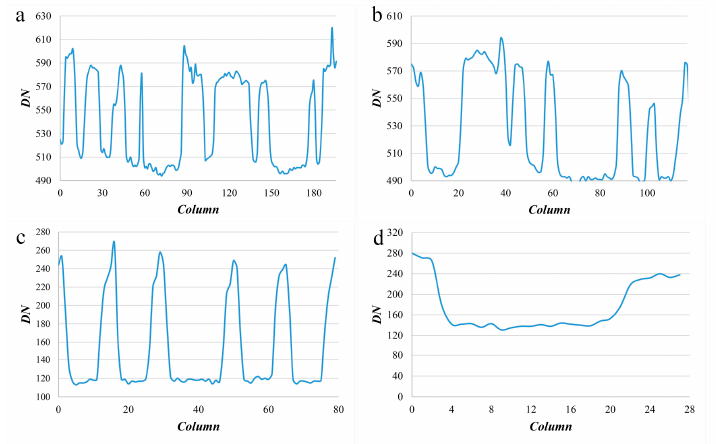
Figure 4. Intensity (Lightness) profiles (only red band is displayed).